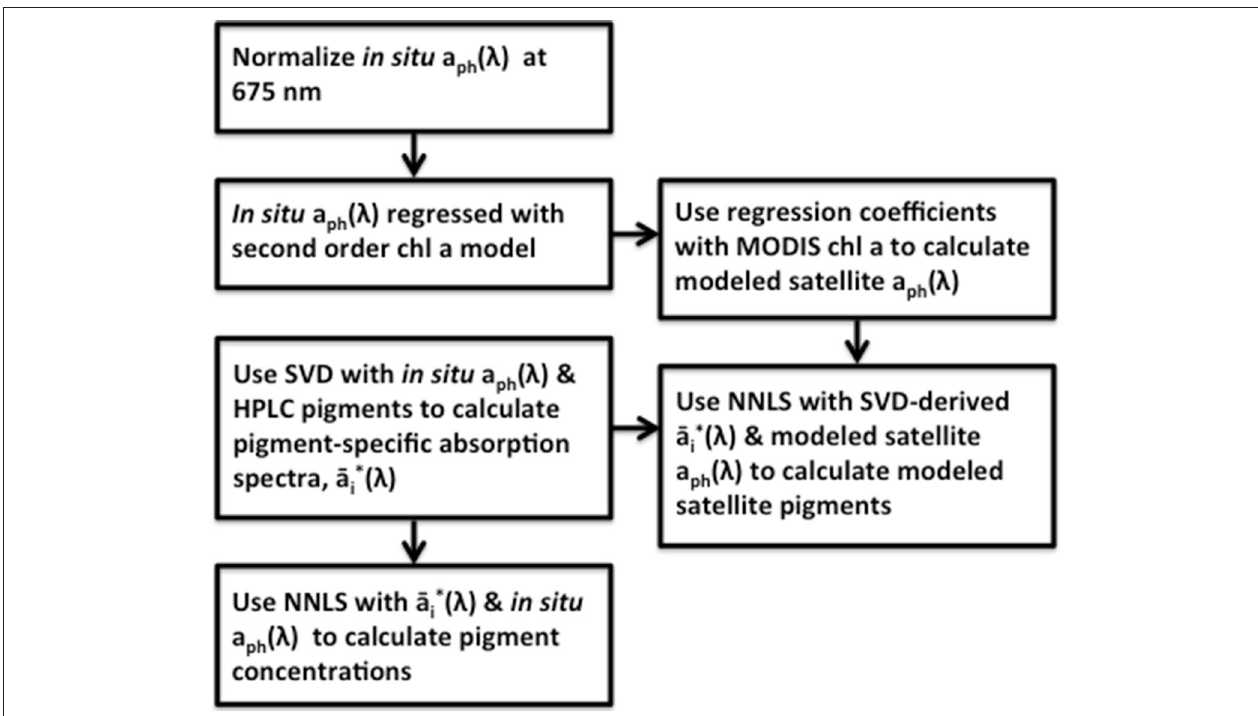
FIGURE 2 | Flow chart of the method utilized in this study to calculate 18 different pigment concentrations along the eastern shore of the United States. The linear absorption spectra model developed in Moisan et al. (2013) is modified and used with the matrix inversion techniques developed in Moisan et al. (2011) in order to extend the matrix inversion technique for use with satellite data.